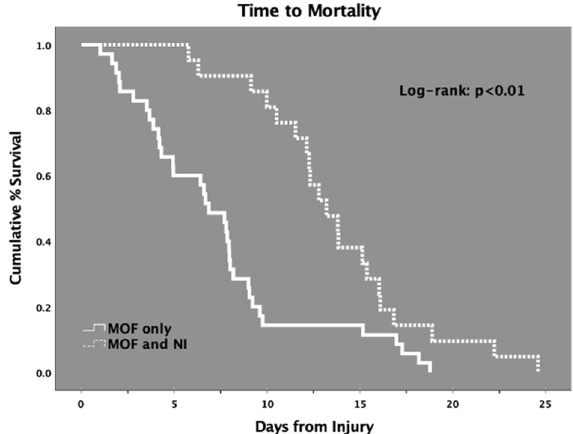
Figure 4. Time to mortality.